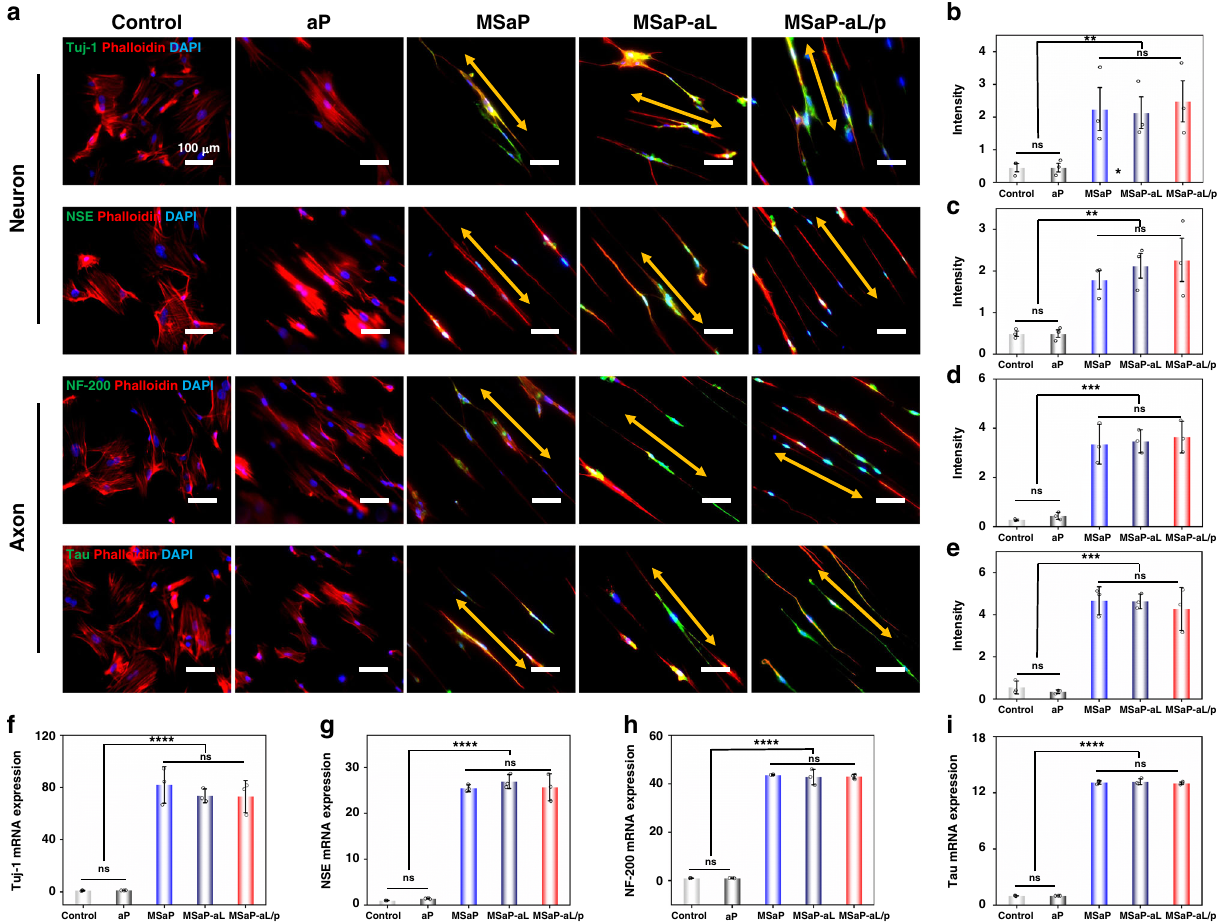
Fig. 7 Neuron-speci fi c marker expression. a Immuno fl uorescence staining of Tuj-1, NSE, NF-200, and Tau staining images on different fi ber scaffolds (scale bars were 100 µ m, 4 independent experiments) with b – e corresponding fl uorescence semi-quantitative analysis. f – i mRNA expression analysis of Tuj-1, NSE, NF-200, and Tau. The yellow bi-directional arrows represented the contact guiding effect of oriented nano fi bers on stem cells ( n = 3, all values were mean ± std. dev., ** p < 0.01, *** p < 0.001, and **** p < 0.0001 when comparing microsol electrospun groups (MSaP, MSaP-aL, MSaP-aL/p) and control and aP groups, respectively, via one-way analysis of variance (ANOVA) with Tukey ’ s post hoc test, ns not signi fi